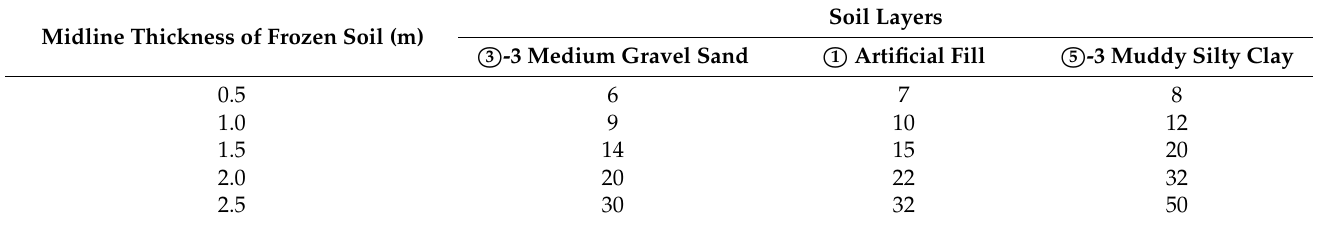
Figure 10. The thickness of frozen soil between jacking pipes.